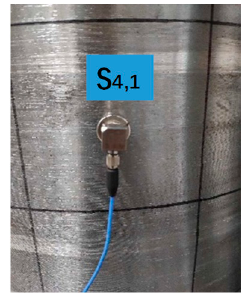
Figure 17. Acceleration sensor installation.